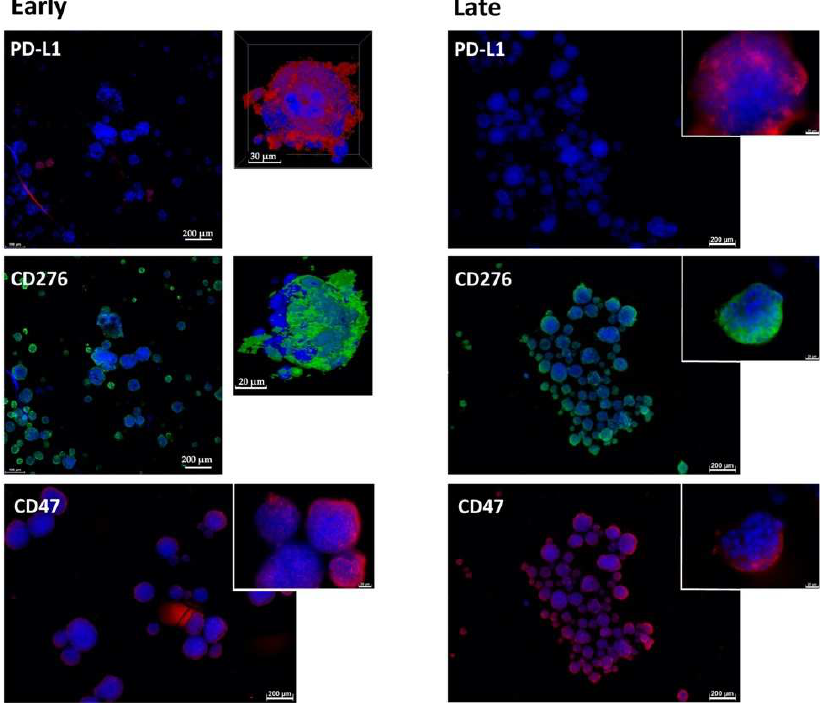
Figure 1. Expression of immune checkpoint antigens on BCO#140 organoids. Organoids of BCO#140, a population with high in vitro growth capacity, were fixed and directly stained in early passage ( left panel ) or in later passage ( right panel ) cultures with antibodies reactive with PD-L1, CD276, and CD47 as indicated. For each staining, an overview with several organoids and a detailed picture of individual organoids are presented. Size bars indicate 200 μm and 20 μm, respectively.